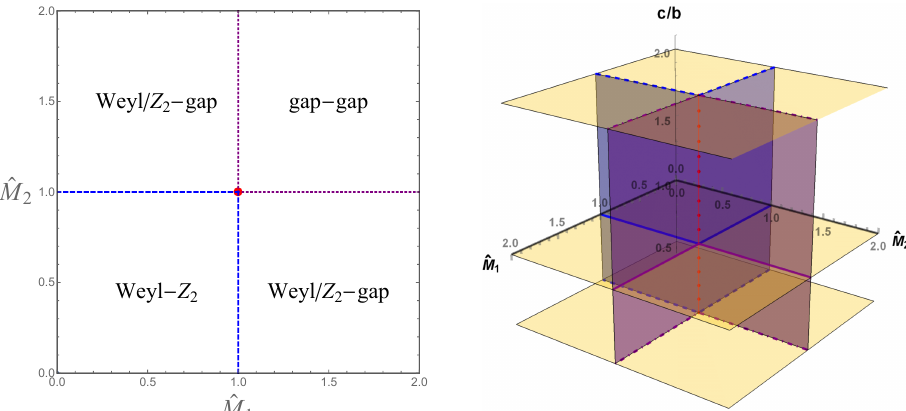
Figure 4. The phase diagram of the system (2.8) with three dimensionless parameters ˆ M 1 = M 1 /b , ˆ M 2 = M 2 /c and c/b = 1 ( left ) and generic c/b ( right ). The red point is the double critical point at which both two pairs of nodes become critical (figure 3(b)). Obviously the phase diagram does not depend on the value of c/b